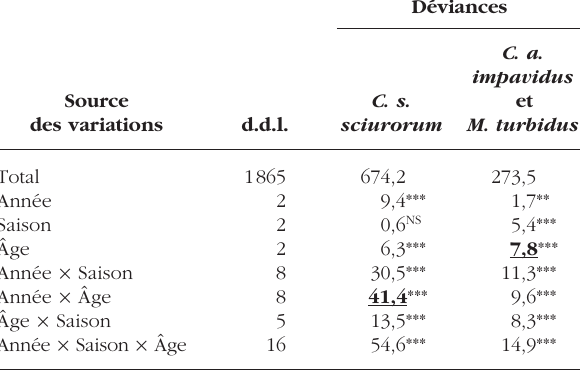
Tableau III. – Analyse de déviance des GLM explorant la variation des abondances en C. s. sciurorum , en C. a. impavidus et M. tur- bidus confondues, en fonction de l’année, de la saison, et de l’âge, chez les tamias capturés entre 2004 et 2006 en Forêt de Sénart. Les